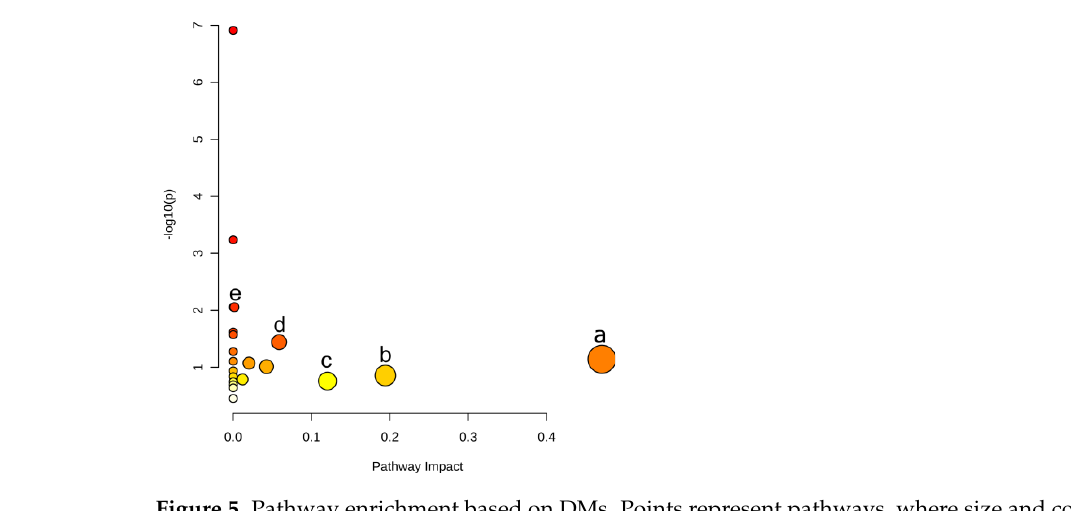
Figure 5. Pathway enrichment based on DMs. Points represent pathways, where size and color are correlated with the pathway impact. ( a ) Phenylalanine metabolism, ( b ) Alanine, aspartate and glutamate metabolism, ( c ) Tryptophan metabolism, ( d ) Phenylpropanoid biosynthesis, ( e ) Phenylalanine, tyrosine and tryptophan biosynthesis. Table 1. Matched features in KEGG pathways analysis.